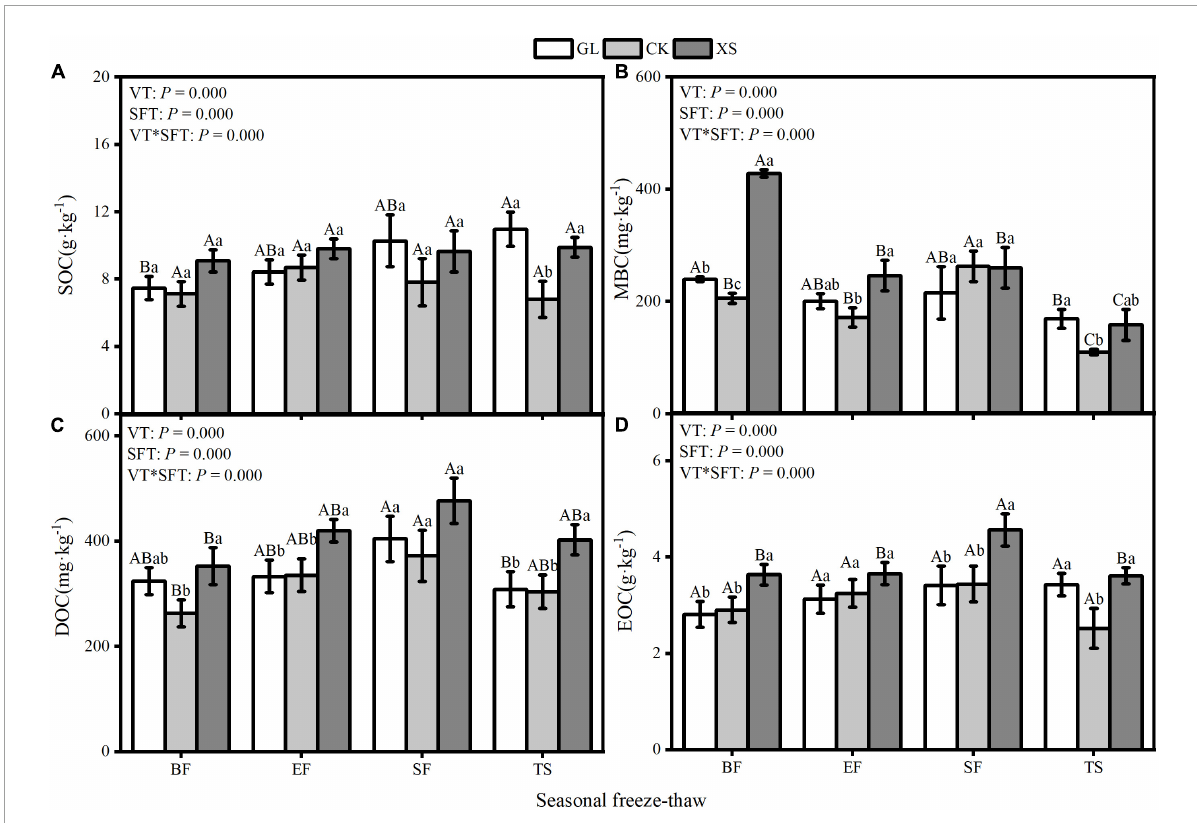
FIGURE3 Seasonal freeze-thaw (FT) dynamics of SOC [ (A) ; Soil organic carbon], MBC [ (B) ; Microbial biomass carbon], DOC [ (C) ; Dissolved organic carbon], and EOC [ (D) ; Easily oxidized organic carbon] contents in 0–40 cm soil layers under different vegetation restoration types. GL, Grassland; CK, Caragana korshinskii ; XS, Xanthoceras sorbifolia ; BF, Before freezing; EF, Early stages of freezing; SF, Stable freeze stage; TS, Thawing stage. VT, SFT denote Type of vegetation restoration, Seasonal FT processes. Error bars indicate standard error of the mean ( n = 3). According to the LSD multiple variance test, different capital letters indicate significant differences between seasonal FT processes for each indicator under the same vegetation type; different lowercase letters indicate significant differences between vegetation types under the same seasonal FT process ( P <